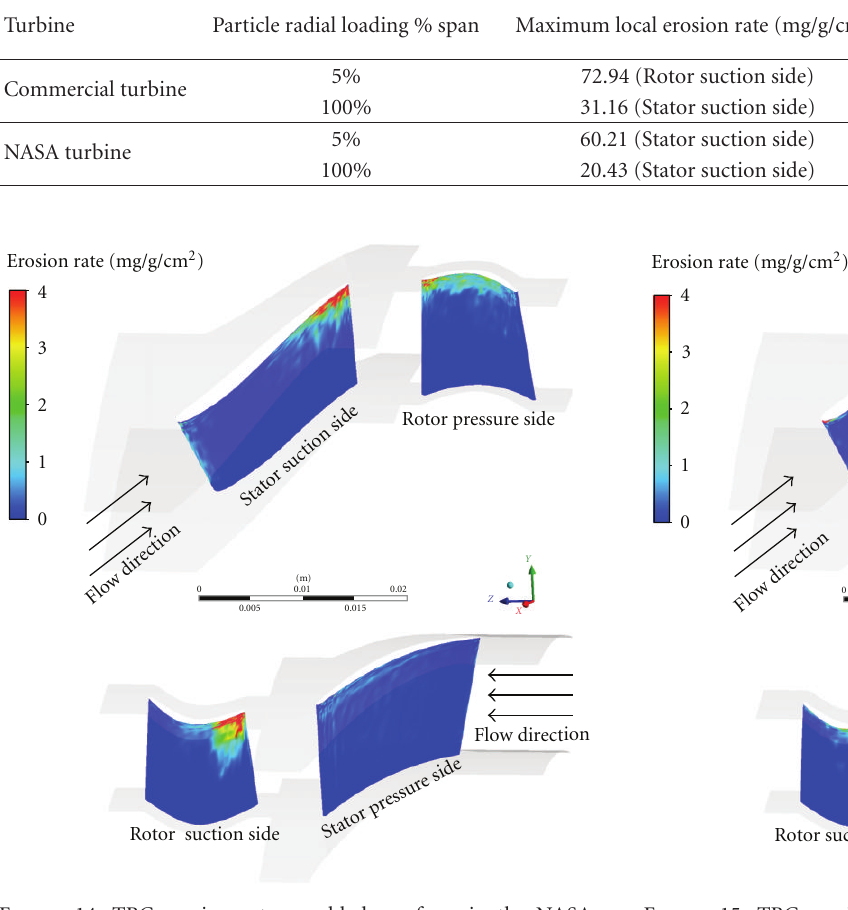
Figure 15: TBC erosion rates on blade surfaces in the NASA- designed turbine for particles seeding within 5% of stator blade span near the hub and shroud at 50% of the gas